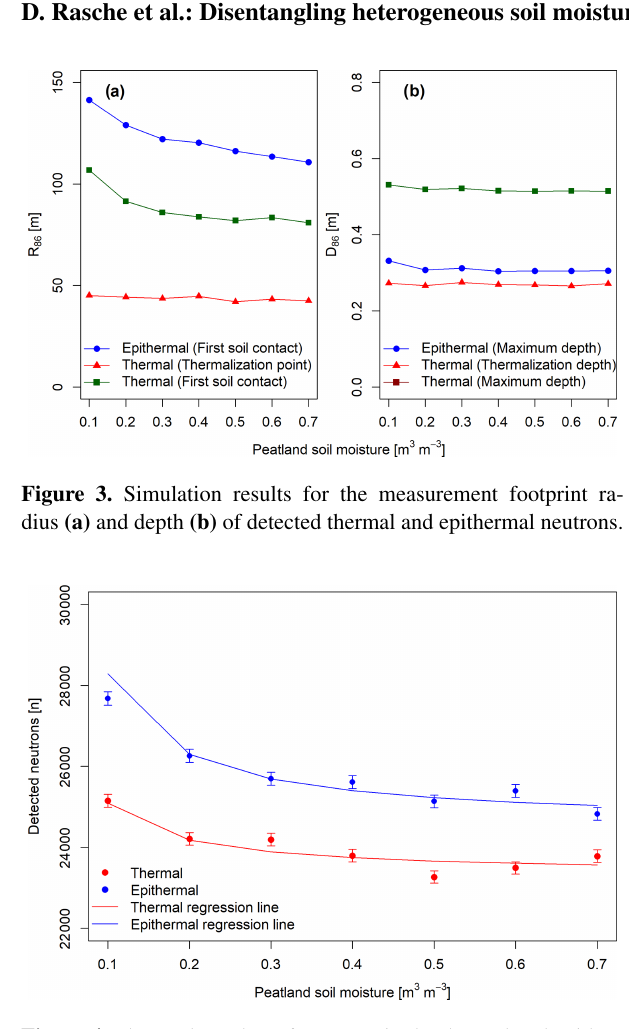
Figure 4. The total number of neutrons in the thermal and epither- mal energy range observed by the virtual detector per simulated peatland soil moisture.